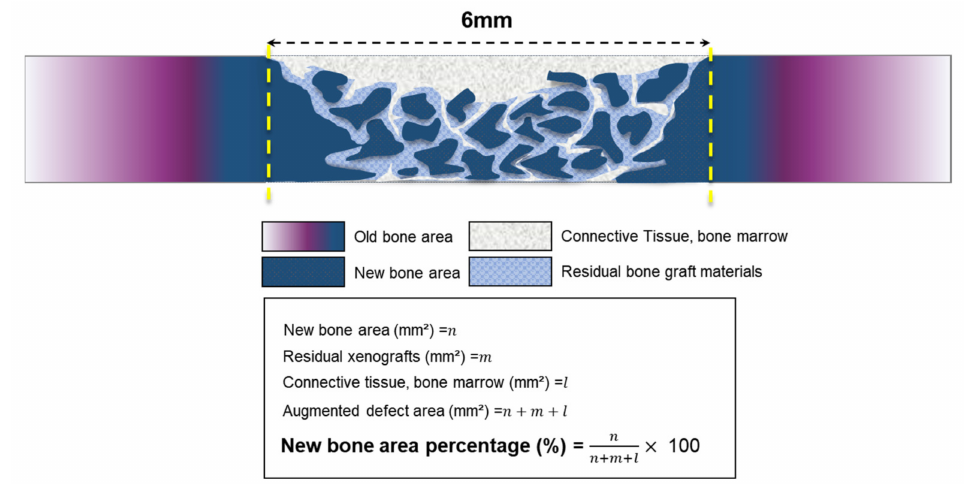
Figure 4. Schematic diagram of histometric